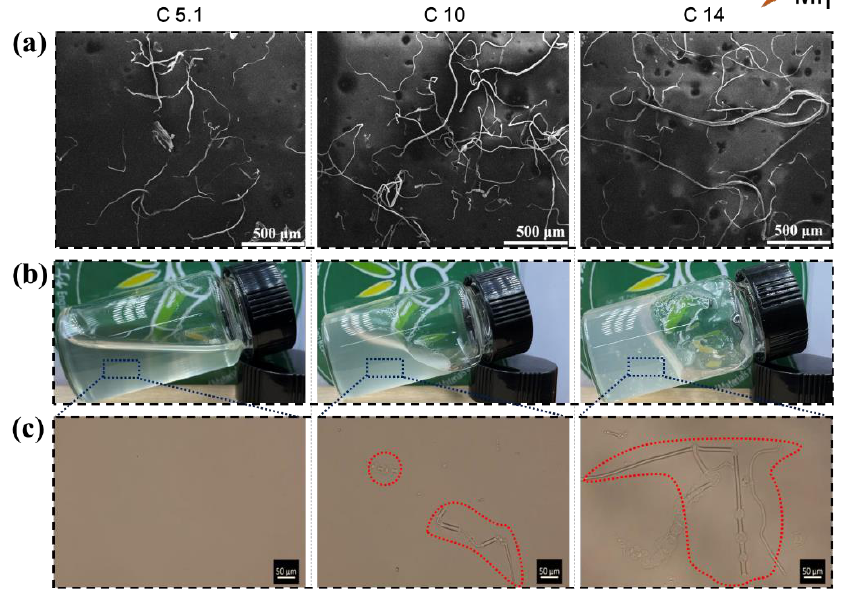
Figure 6. ( a ) The SEM images of bamboo cellulose with the M η of C5.1 and C10 and C14. ( b ) Optical pictures of bamboo cellulose solutions with the M η of C5.1 and C10 and C14. ( c ) Optical microscope images of bamboo dissolving solutions with the M η of C5.1 and C10 and C14.